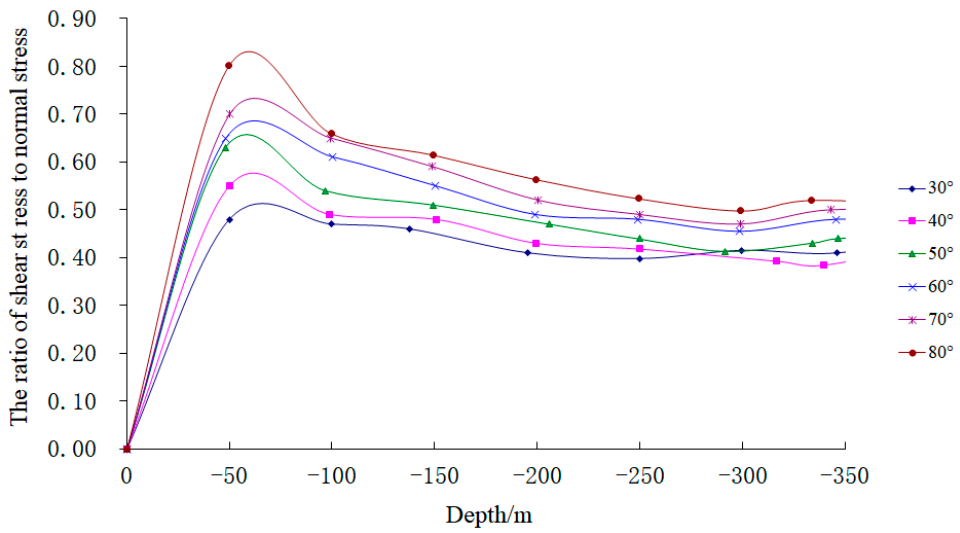
Figure 17. The shear stress to normal stress ratio distribution on the fault plane at various fault dip angles.